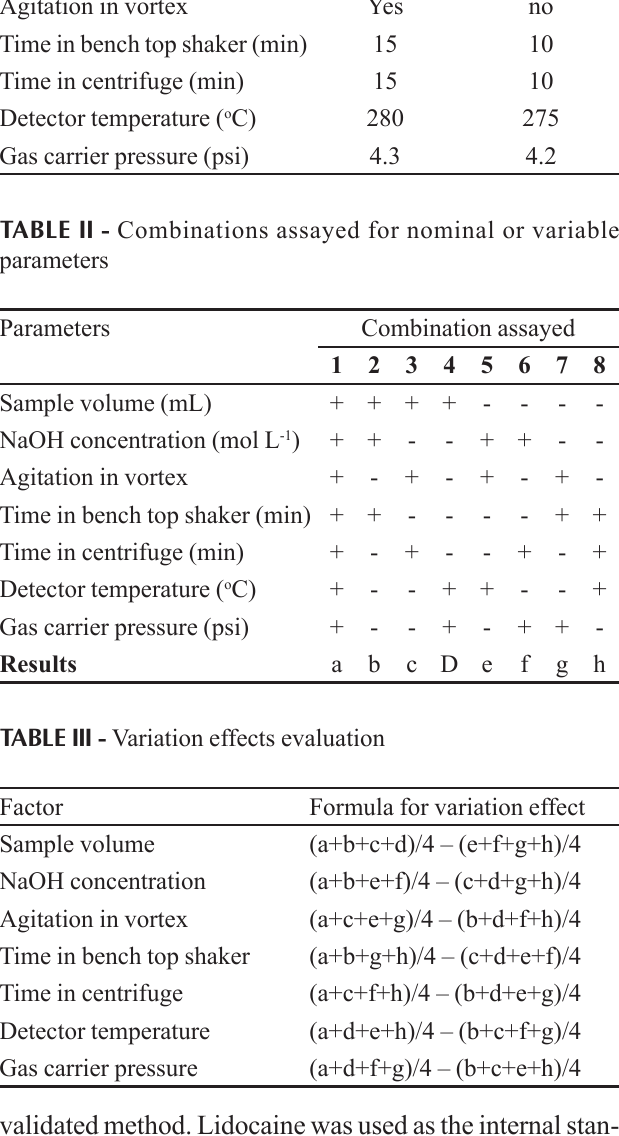
FIGURE 1 - Chromatograms after LLE of urine: a) non smokers; b) passive smokers; c) active smokers. (1) Cotinine: rt 5.7 min; k’ 2.0 min; α 1.25 (calculated between cotinine and immediately before peak) (2) Lidocaine (IS): rt 8.2 min; k’ 3.3 min; α 1.1 (calculated between cotinine and immediately after peak). Chromatographic conditions: ZB-1 column, injector temperature at 260 o C, the oven temperature programmed with initial temperature of 180 o C, ramp 1: 30 o C/ minute to 250 o C for 0.5 min; ramp 2: 15 o C/ min to 259 o C for 0.1 min and ramp 3: 0.1 o C/min to 260 o C, detector temperature at 280 o C. Nitrogen as gas carrier at 4.3